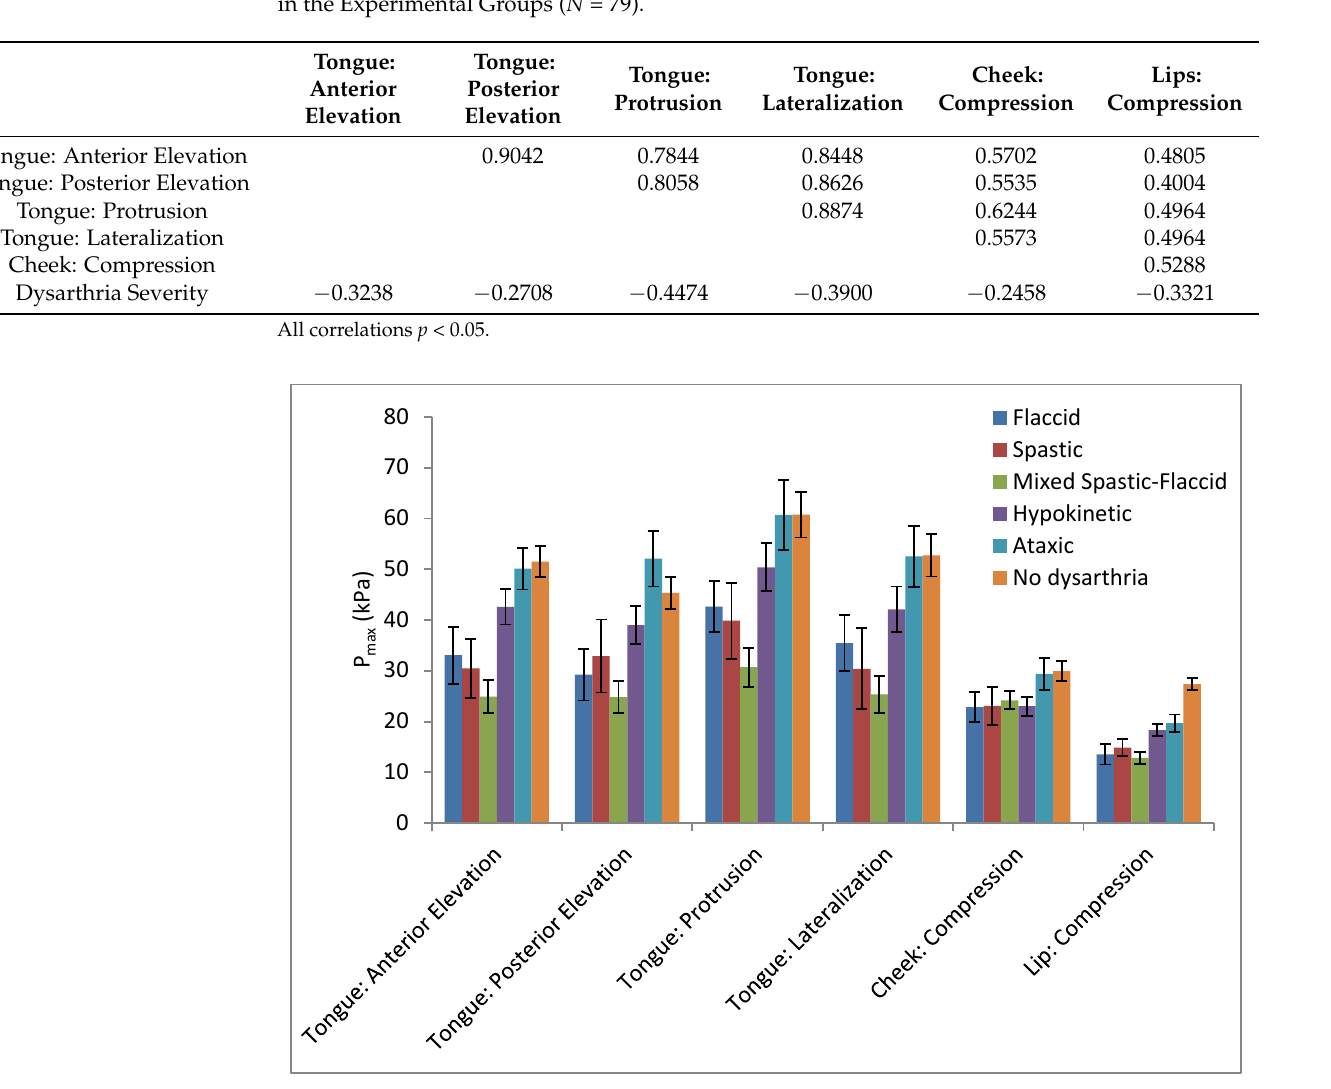
Table 4. Pearson Correlations Among Orofacial Strength Measures for All Participants ( N = 112), and Spearman Correlations Between Orofacial Strength Measures and Dysarthria Severity for Par- ticipants in the Experimental Groups ( N = 79).